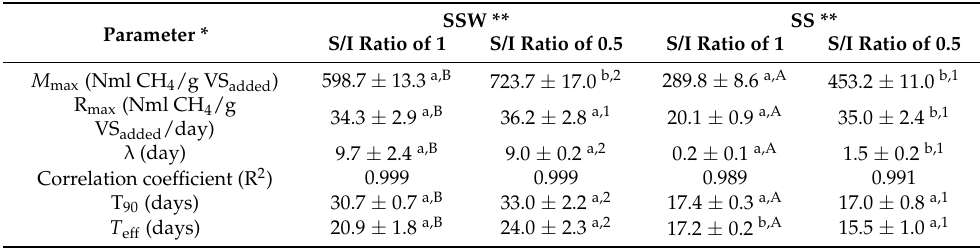
Table 5. Anaerobic digestion parameters of SSW and SS estimated using the modified Gompertz formula (Equation (6)).